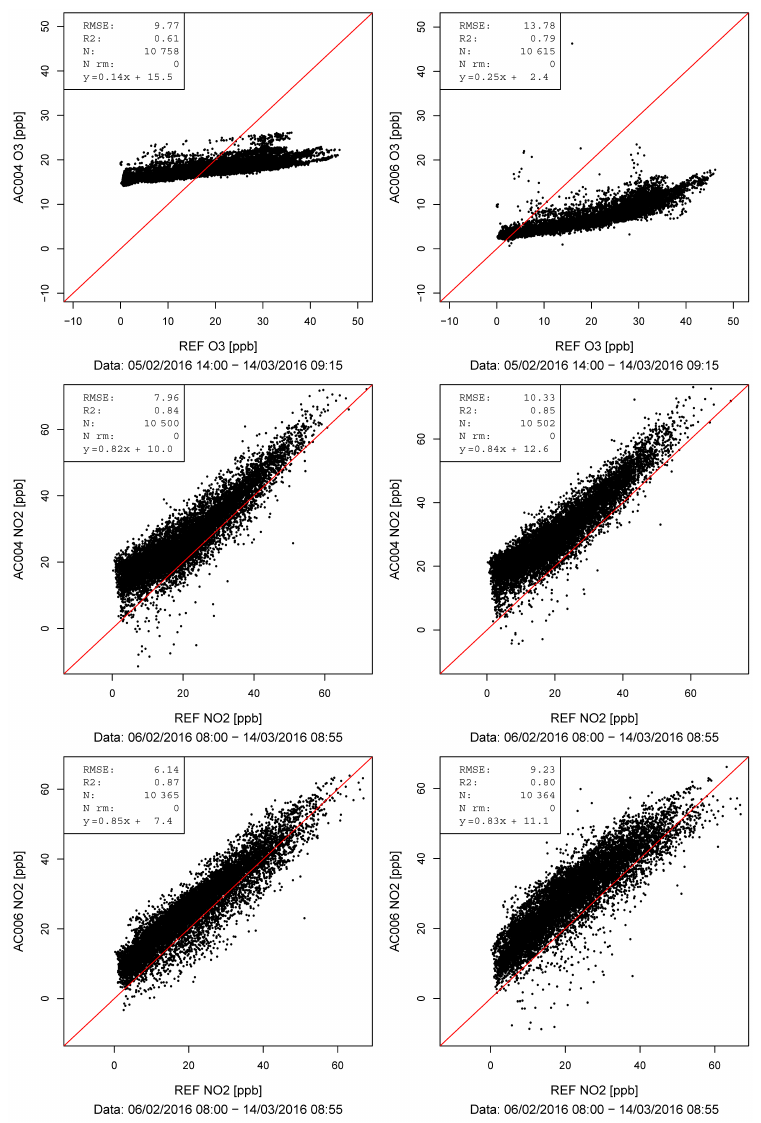
Figure 10. Comparison of the measurements from sensors integrated in SU004 and SU006 (DS 2) to measurements from the AQM site SCH during the second calibration in the period February to March 2016. Top row: O 3 sensor no. 0 of SU004 and SU006. Middle row: NO 2 B42F sensors no. 0 and 1 of SU004. Bottom row: NO 2 B4 sensors no. 0 and 1 of SU006. The selected sensors are